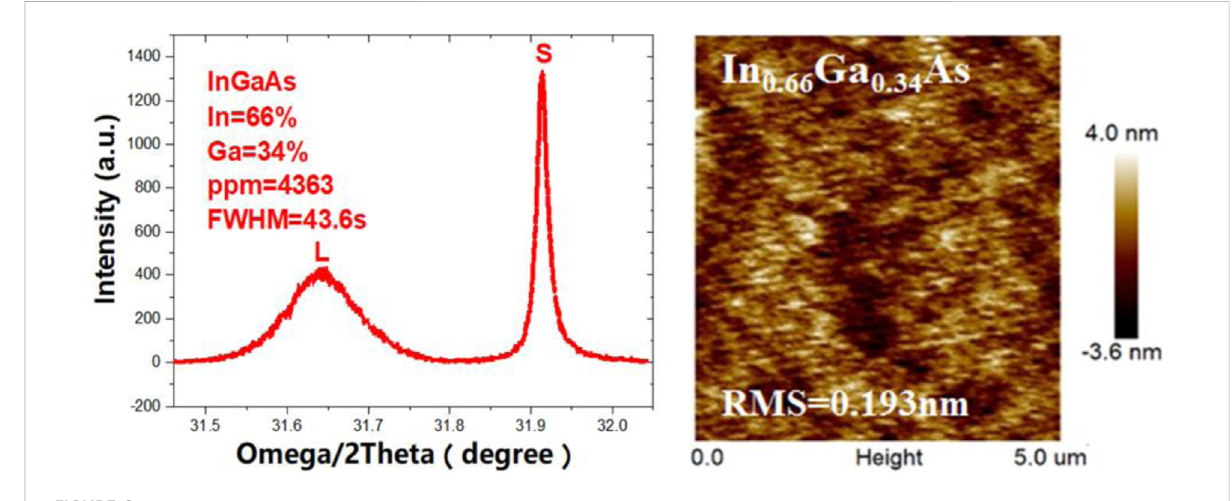
FIGURE 6 The HRXRD swing curve and the AFM images of In 0.7 Ga 0.3 As.